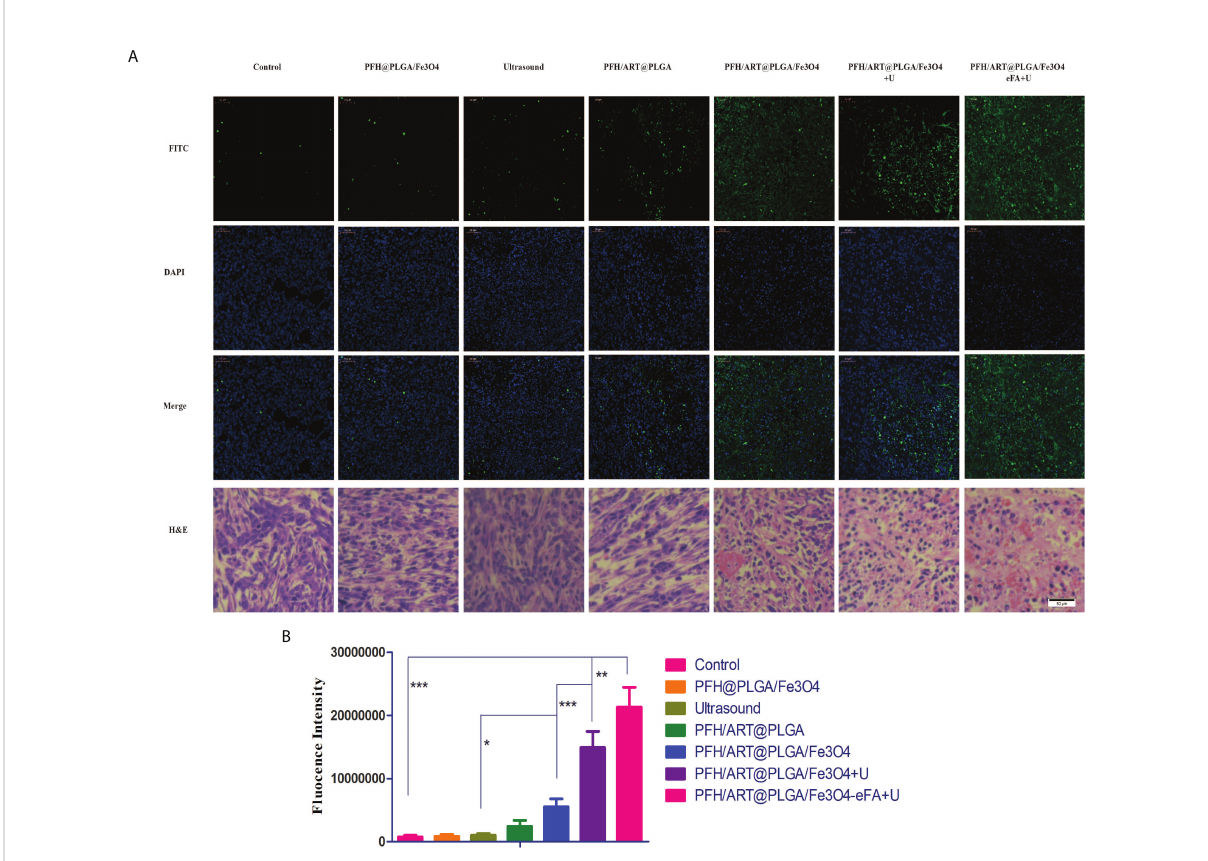
FIGURE 9 In vivo treatment. (A) H&E and TUNEL staining of the tumors15d after the different treatments.Nuclei and apoptotic cells were stained blue and green, respectively. (B) Quantitative analysis of the fl uorescence intensity of TUNEL staining. Scale bars indicate 50 µm. The levels of signi fi cance wereset to values of *p < 0.05, **p < 0.01, and ***p < 0.001. The data are shown as the mean ± s.d. n =